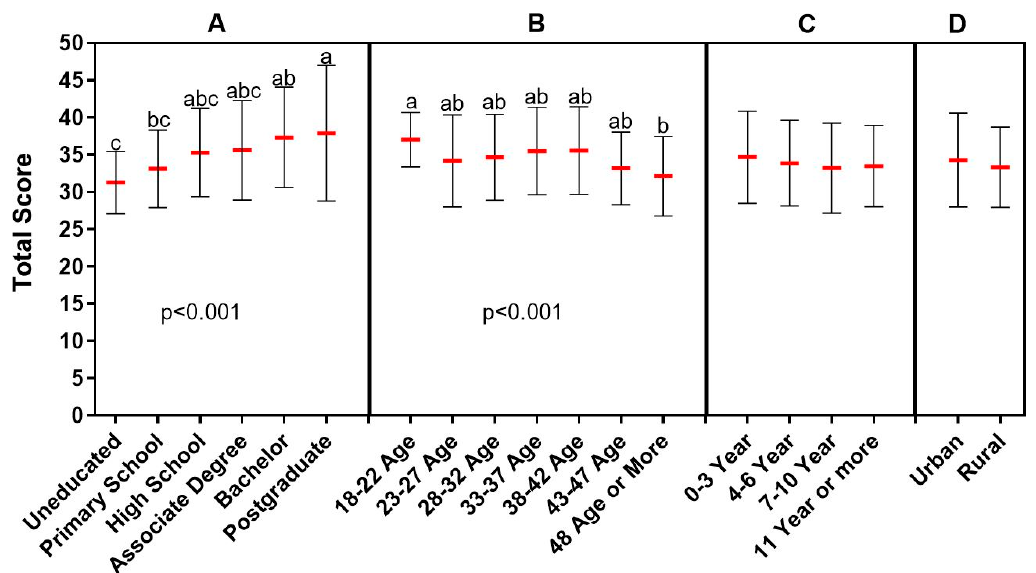
Figure 4. Relationship between knowledge level of participants on antibiotic use and demographic